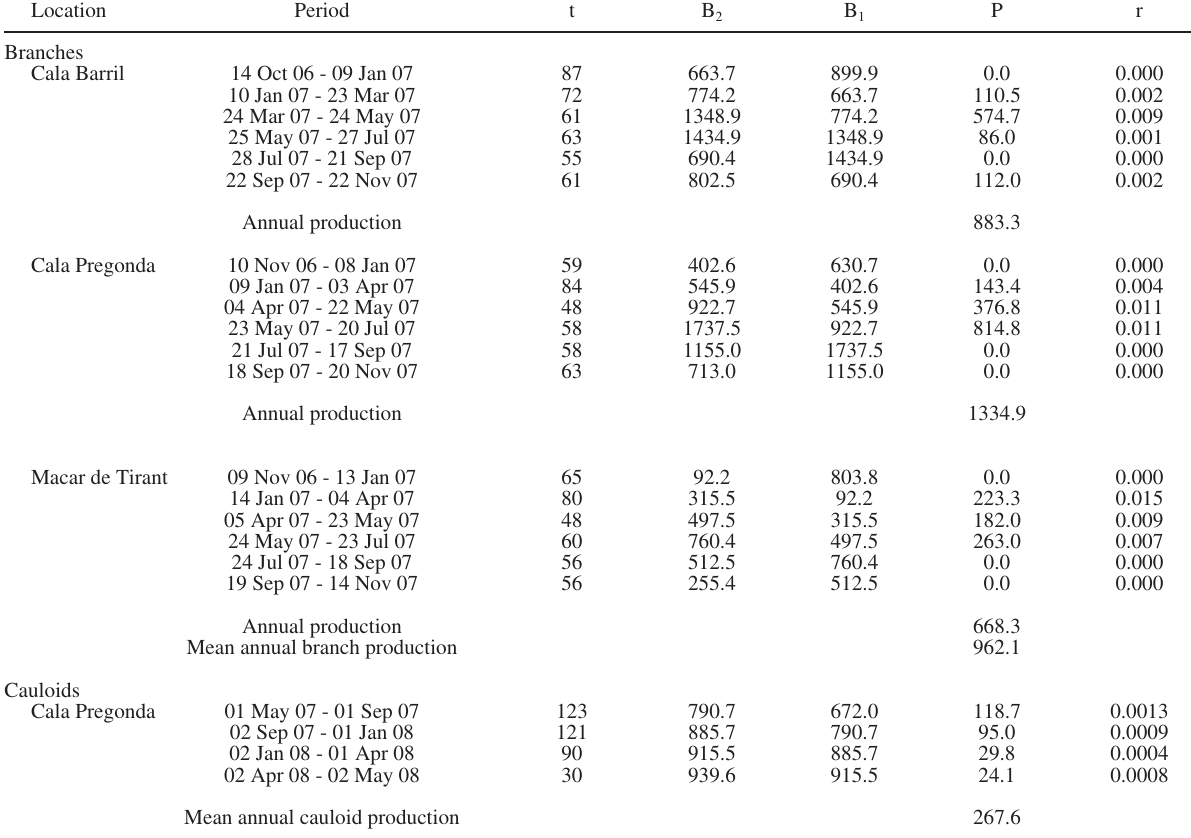
Table 4. – Annual production of C. crinita branches and cauloids. t: time (days), B at the beginning of the period, P: production (g dwt m –2 ), r (daily biomass turnover